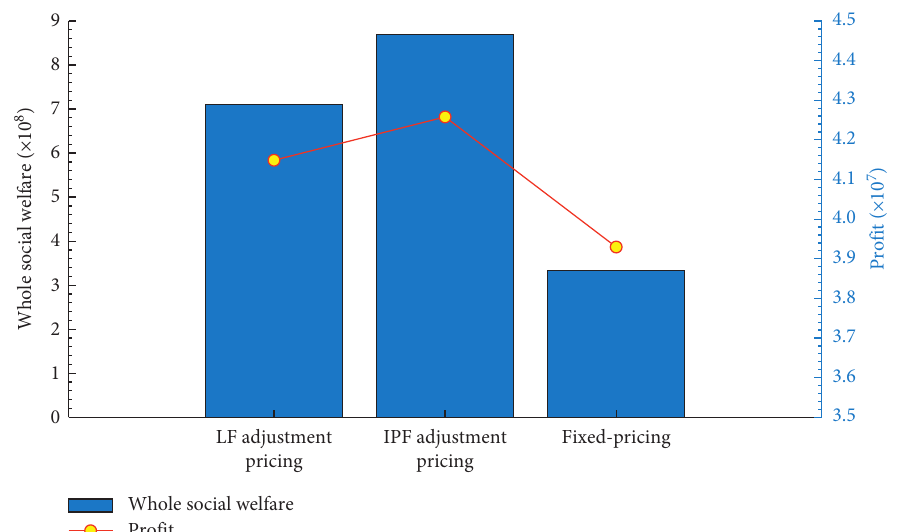
Figure 6: Comparison of economic benefits (histogram denotes whole social welfare and red solid lines with point markers indicate profit).